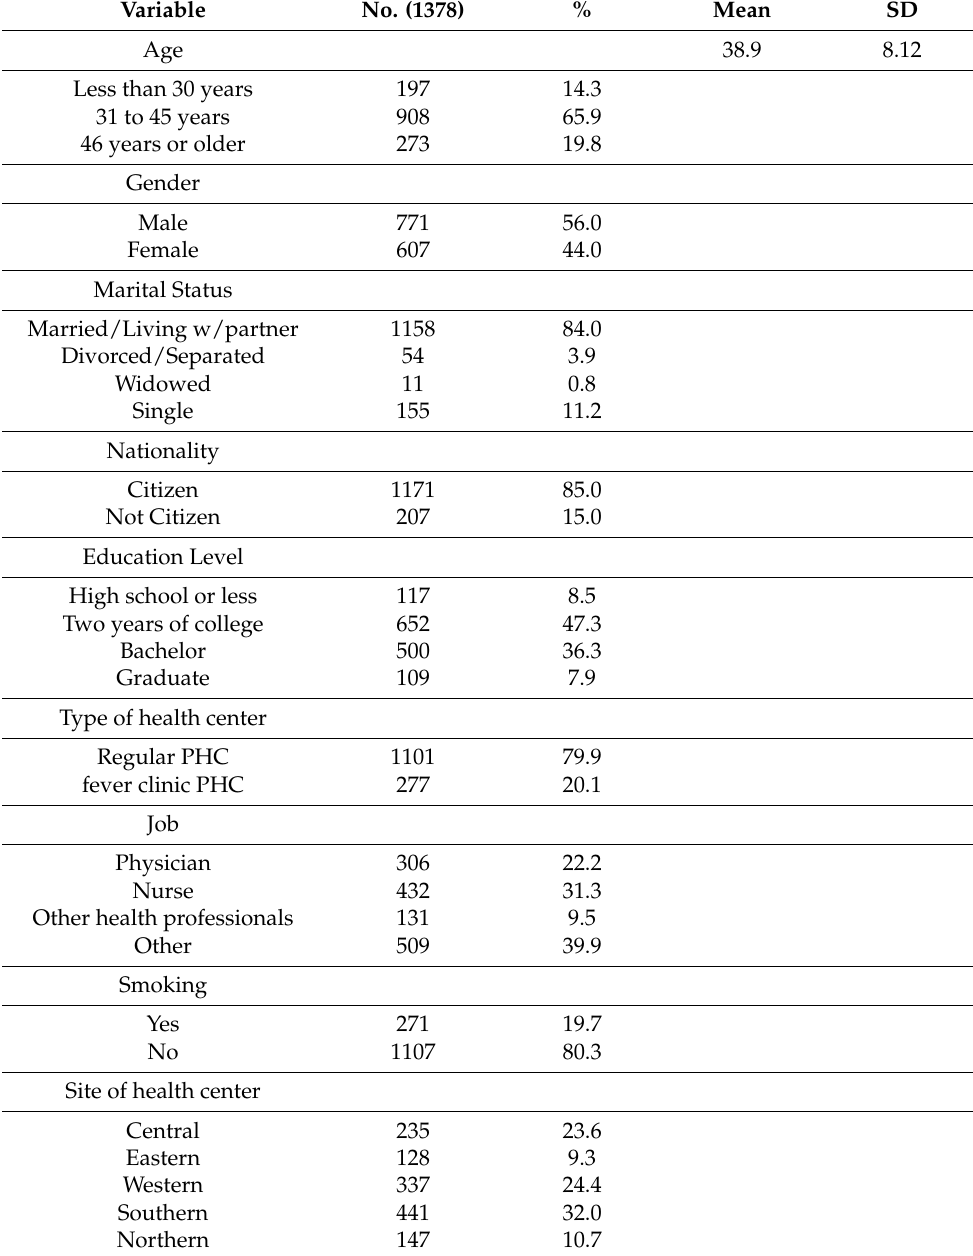
Table 1. Socio-demographic Characteristics of studied